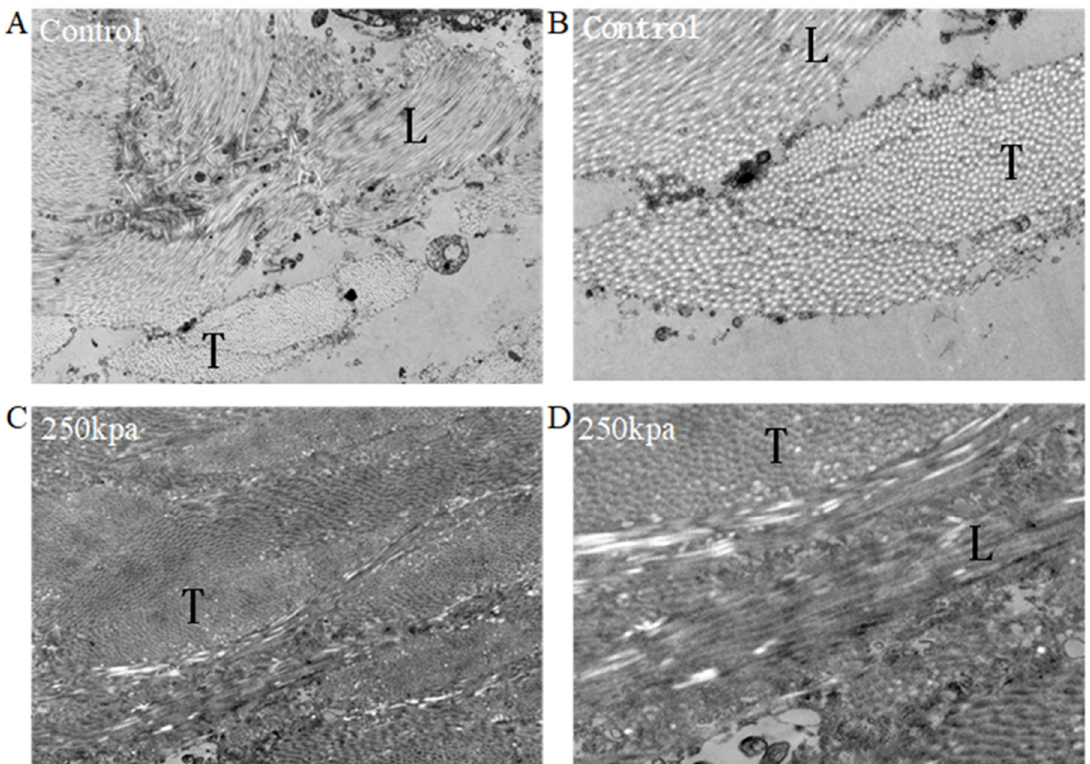
Figure 3. Representative TEM of unfused and fused small intestine. ( A , B ) Electron micrograph of control (unfused) small intestine ( A : magnification 3000 × , B : magnification 7000 × ). ( C , D ) Electron micrograph of fused small intestine at 250 kPa (( C ): magnification 3000 × , ( D ): magnification 7000 × ). T, transverse-section of collagen fibrils; L, longitudinal-section of collagen